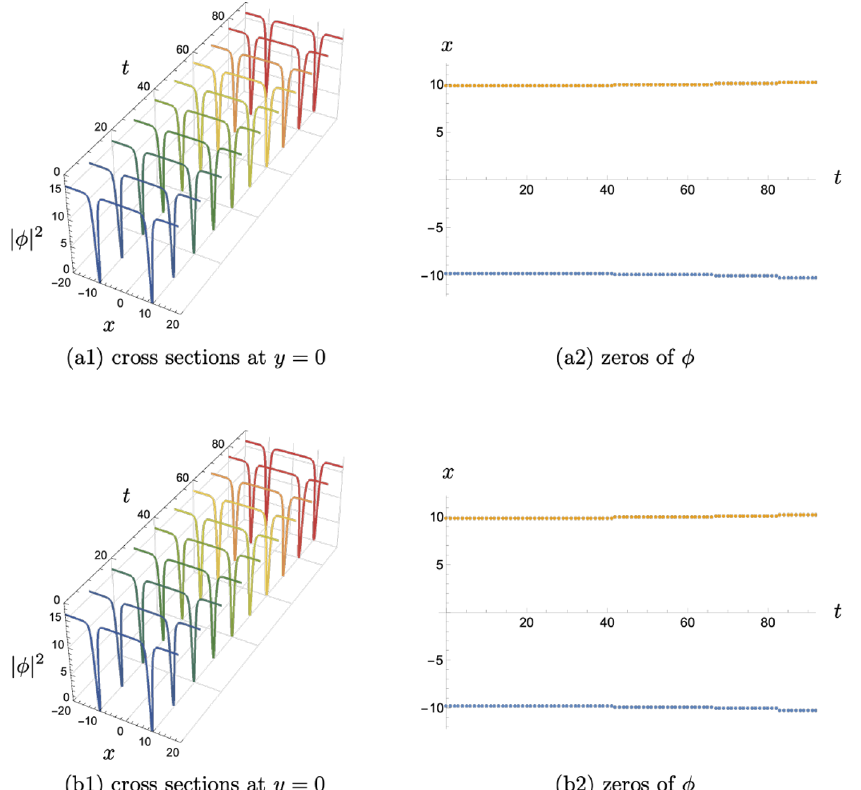
Figure 17 . The inter-vortex forces for type II non-Abelian vortices with ( m χ /m φ , m γ /m φ ) = √ (0 . 25 , 0 . 1) , or more explicitly ( v = 4 , λ = 1 / 4 , e = 1 / 10 2 , Ω = 1 ). Panels (a1) and (a2) are for parallel vortices, whereas panels (b1) and (b2) are for anti-parallel vortices. Panels on the left show time evolution of | φ | 2 (cross sections at y = 0 ), while panels on the right present the x -position of the vortex centers from t = 0 to t = 90 .